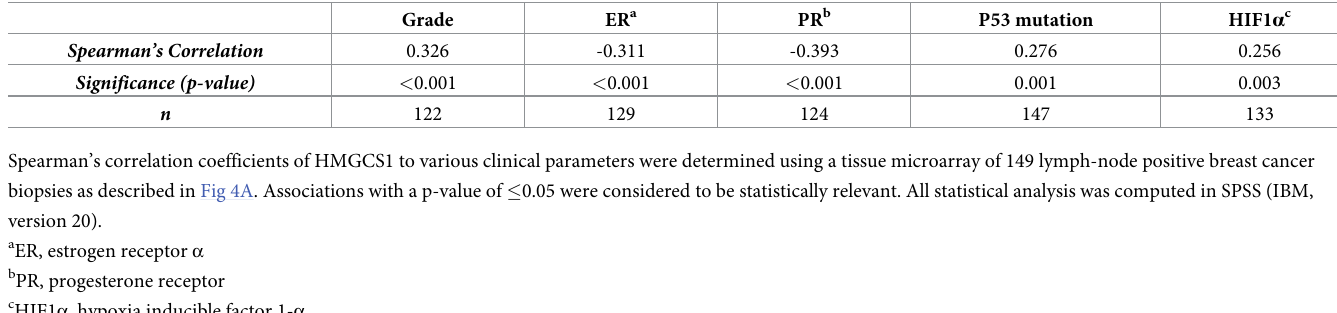
Table 1. Clinical associations of HMGCS1 in a lymph node positive breast cancer patient cohort.